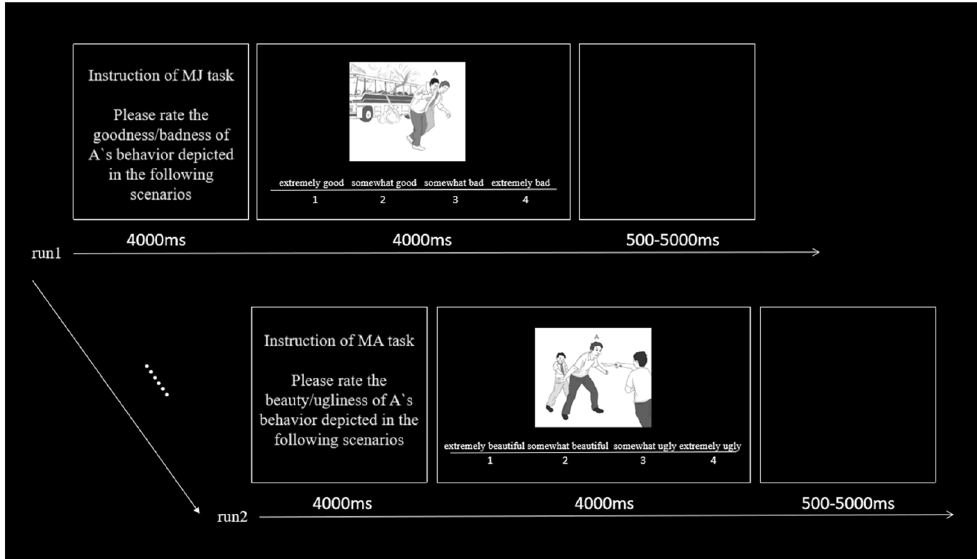
Figure 2. The experimental flowchart. Stimuli were scene drawings of positive or negative behaviors with two different moral degrees. Subjects were required to rate the degree of goodness or badness about the morally positive behaviors or negative behaviors in the morality judgment, as well as to rate the degree of beauty or ugliness about the morally positive behaviors or negative behaviors in the moral aesthetic judgment. The order of the two tasks was counterbalanced across